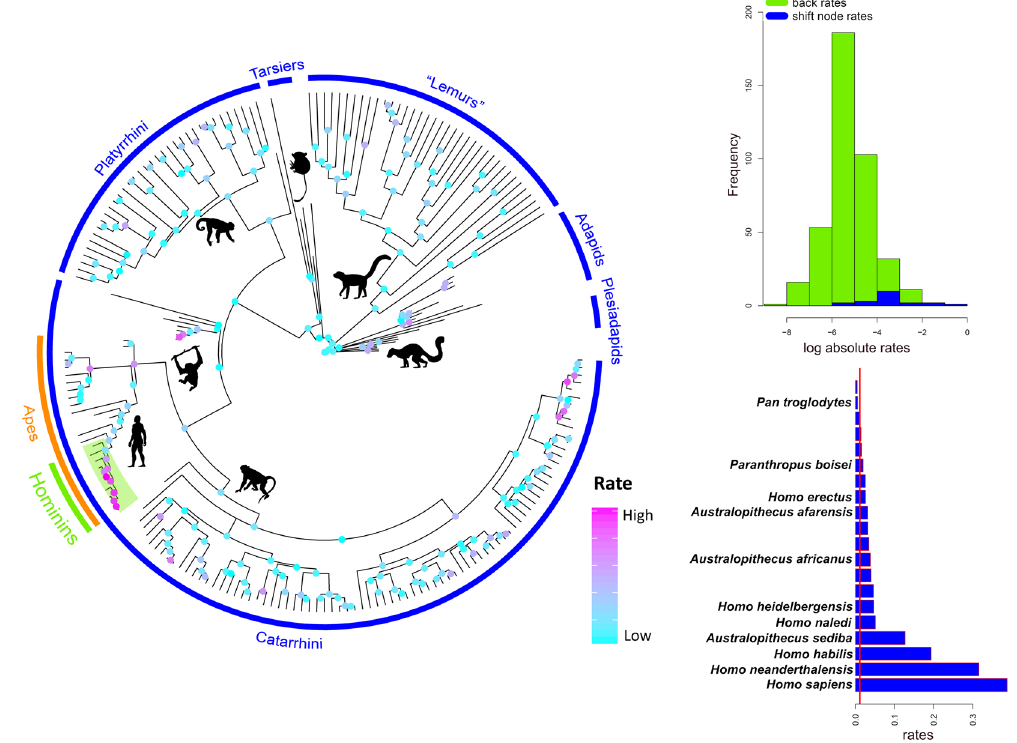
Figure 2. The evolutionary rates of mandible shape on the primate tree. The tree on the left reports rates computed according to phylogenetic Ridge Regression (coloured dots, scaled according to the rate value, from low = cyan, to high rates = magenta). The human clade, highlighted with a green semitransparent box, represents the only rate shift as indicated by the variable Brownian rate approach. On top right, the phylogenetic Ridge Regression rates (in absolute values) computed for the branches of the tree not belonging to the human clade (green) are contrasted to rates for the human clade (blue). On bottom right, phylogenetic Ridge Regression rates of individual branches of the human clade (in absolute value) plus the human clade sister species, the common chimpanzee, are collated in increasing rate value (blue bars), and contrasted to the average rate computed over the entire tree (the vertical red line). Bars without names correspond to internal nodes of the human clade. The image was generated by using the R package ggplot (http://ggplot2.org/) and our own R codes. Animal silhouettes were available under Public Domain license at phylopic (http://phylopic.org/), unless otherwise indicated. Specifically, clockwise starting from the bottom, Macaca (http://phylopic.org/image/ eedde61f-3402-4f7c-9350-49b74f5e1dba/); Homo sapiens (http://phylopic.org/image/c089caae-43ef-4e4e- bf26-973dd4cb65c5/); Hylobates (http://phylopic.org/image/0174801d-15a6-4668-bfe0-4c421fbe51e8/); Cebus (http://phylopic.org/image/156b515d-f25c-4497-b15b-5afb832cc70c/) available for reuse under the Creative Commons Attribution 3.0 Unported (https://creativecommons.org/licenses/by/3.0/) image by Sarah Werning; Tarsius (http://phylopic.org/image/f598fb39-facf-43ea-a576-1861304b2fe4/); lemuriformes (http://phylopic. org/image/eefe8b60-9a26-46ed-a144-67f4ac885267/), available for reuse under Attribution-ShareAlike 3.0 Unported (https://creativecommons.org/licenses/by-sa/3.0/) image by Smokeybjb; Plesiadapis (http://phylopic. org/image/b6ff5568-0712-4b15-a1fd-22b289af904d/), available for reuse under Attribution-ShareAlike 3.0 Unported (https://creativecommons.org/licenses/by-sa/3.0/) image by Nobu Tamura (modified by Michael